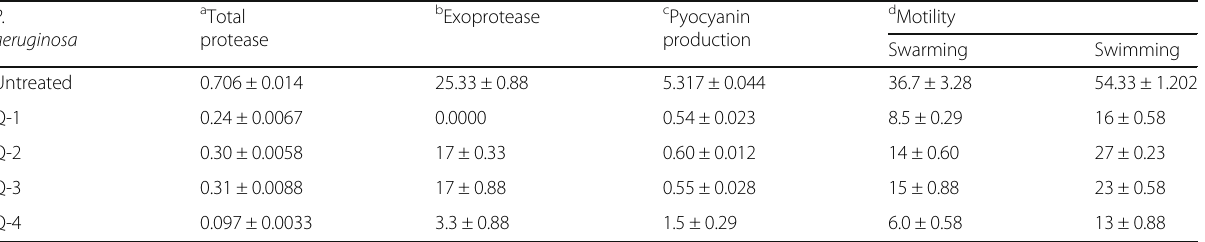
Table 2 Effect of SICs of Q. infectoria gall extracts on of virulence factors in P. aeruginosa . Data are expressed as mean ± SE . a Total protease presented as the absorbance at OD 420, b Exoproteases and d motility (swarming and swimming) data are expressed as the diameter in mm, c Pyocyanin levels were presented as micrograms of pyocyanin produced per microgram of total protein